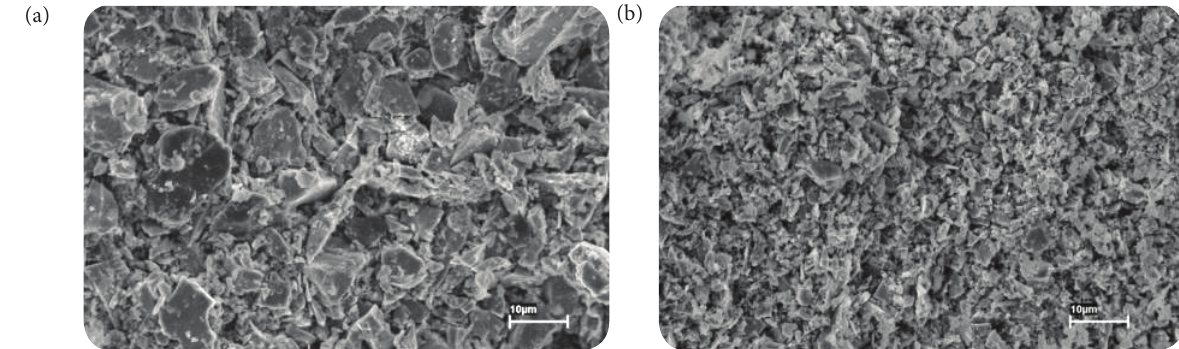
Figure 4. SEM micrographs of the fracture surface of samples after CIP compaction: (a) AZ-10SiC and (b) MZ-10SiC.